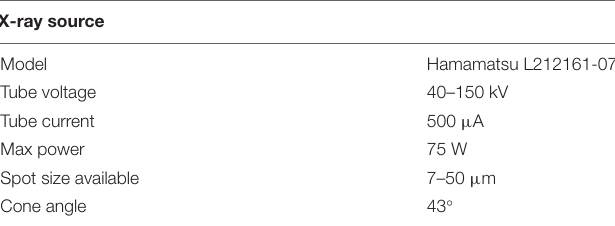
TABLE 4 | X-ray imaging parameters for bimodal imaging at ICON (Kaestner et al., 2017). X-ray source